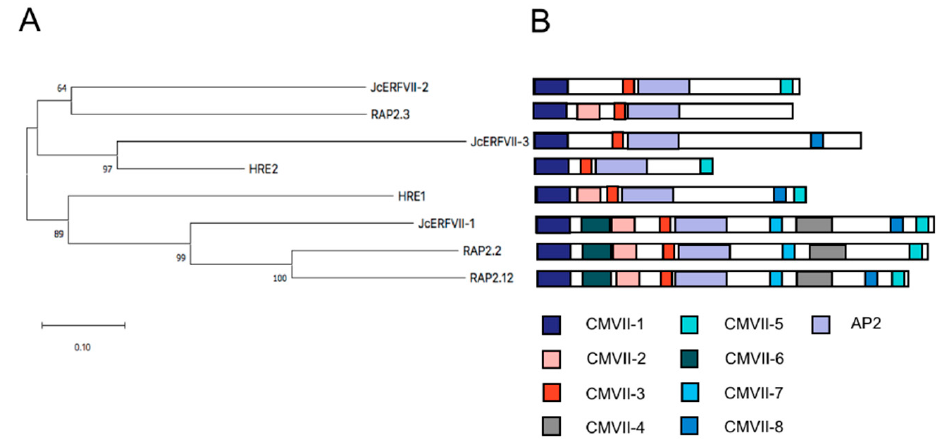
Figure 1. Phylogenetic and domain architecture analysis of Jatropha ERFVIIs. ( A ) The phylogenetic tree based on the amino acid sequence of Arabidopsis and Jatropha ERFVIIs. The numbers are bootstrap values after 1000 replicates. Scale bar represents genetic distance. ( B ) Diagram representing domain architecture of Jatropha ERFVIIs following previously published motifs [5] .